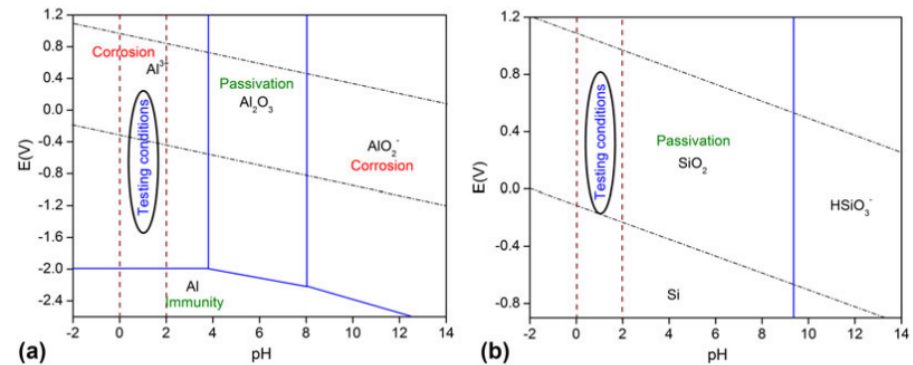
Figure 75. Pourbaix diagrams for ( a ) aluminum and ( b ) silicon, showing the regions of corrosion, immunity, and passivation [205]. Copyright 2014. Adapted with permission from Cambridge University Press under the license number 4605401109358 (Figure 12 [205]), dated 24 May 2019.